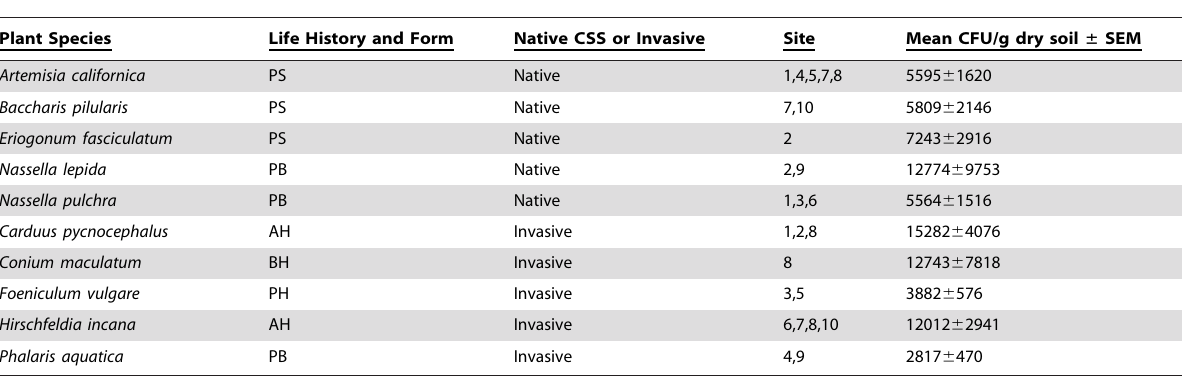
Table 1. PPFM abundance associated with the root zone of the different plant species.